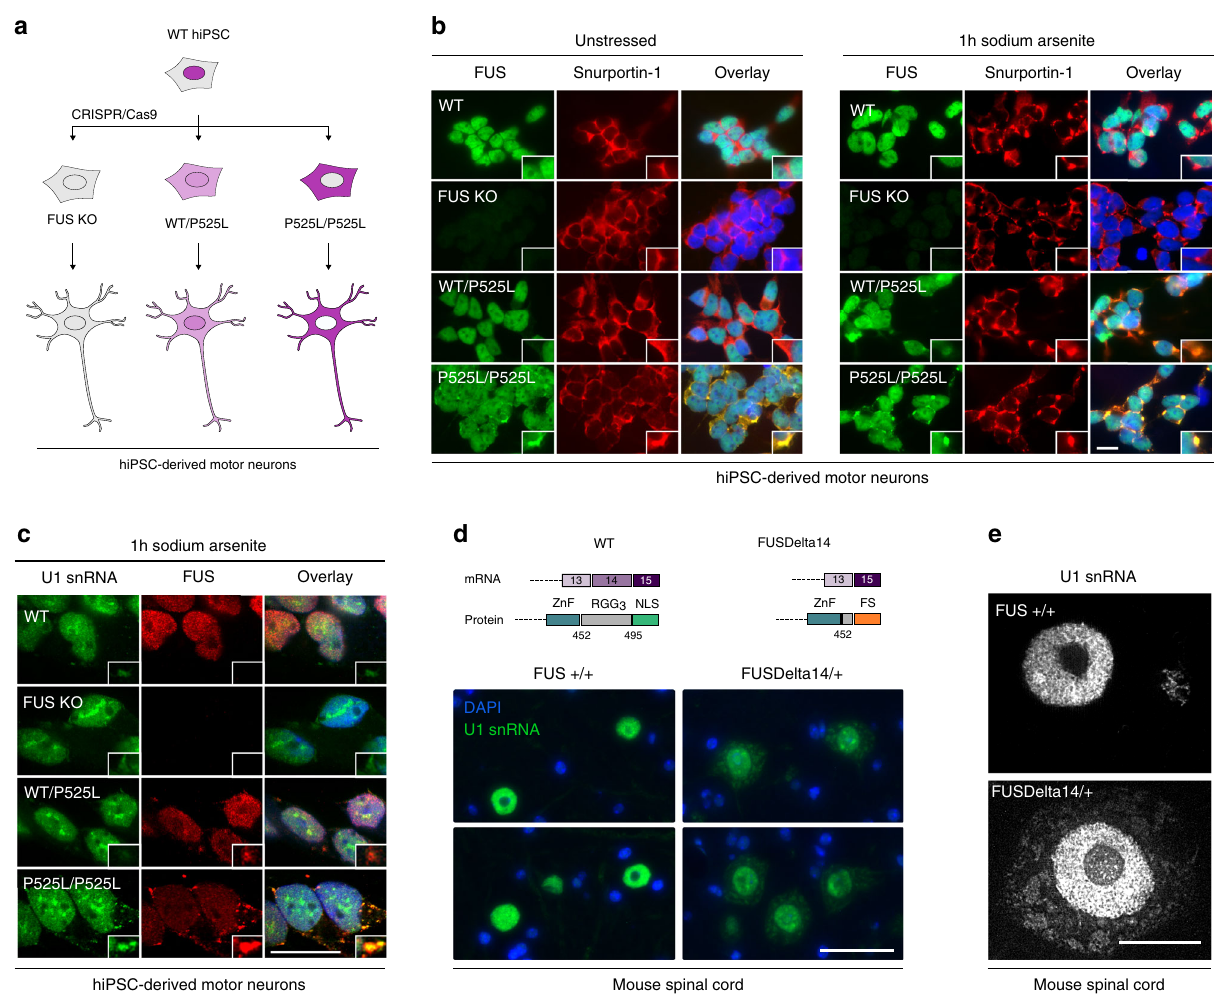
Fig. 5 ALS-associated FUS traps U1 snRNA in the cytoplasm of motor neurons. a Schematic representation of the genome-edited hiPSC-derived motor neurons used in this study. b Immunostaining in hiPSC-derived motor neurons with and without sodium arsenite treatment. FUS (green) and Snurportin-1 (red) were visualised using respective antibodies. Nuclei were counterstained with DAPI. Scale bar = 15 µ m, n = 2. c Combined FISH and immunostaining in hiPSC-derived motor neurons following sodium arsenite treatment. FUS was visualised using anti-FUS antibodies (red), U1 snRNA with 6-FAM azide- labelled antisense probe (green). Nuclei were counterstained with DAPI. Scale bar = 15 µ m, n = 1. d RNA FISH in 18-month spinal cord sections of WT and ‘ FUSDelta14 ’ mice. U1 snRNA was visualised using 6-FAM azide-labelled antisense probe. Scale bar = 75 µ m, n = 5. e High-resolution images of motor neurons from the same sections as the images in panel d. Scale bar = 15 µ m, n =